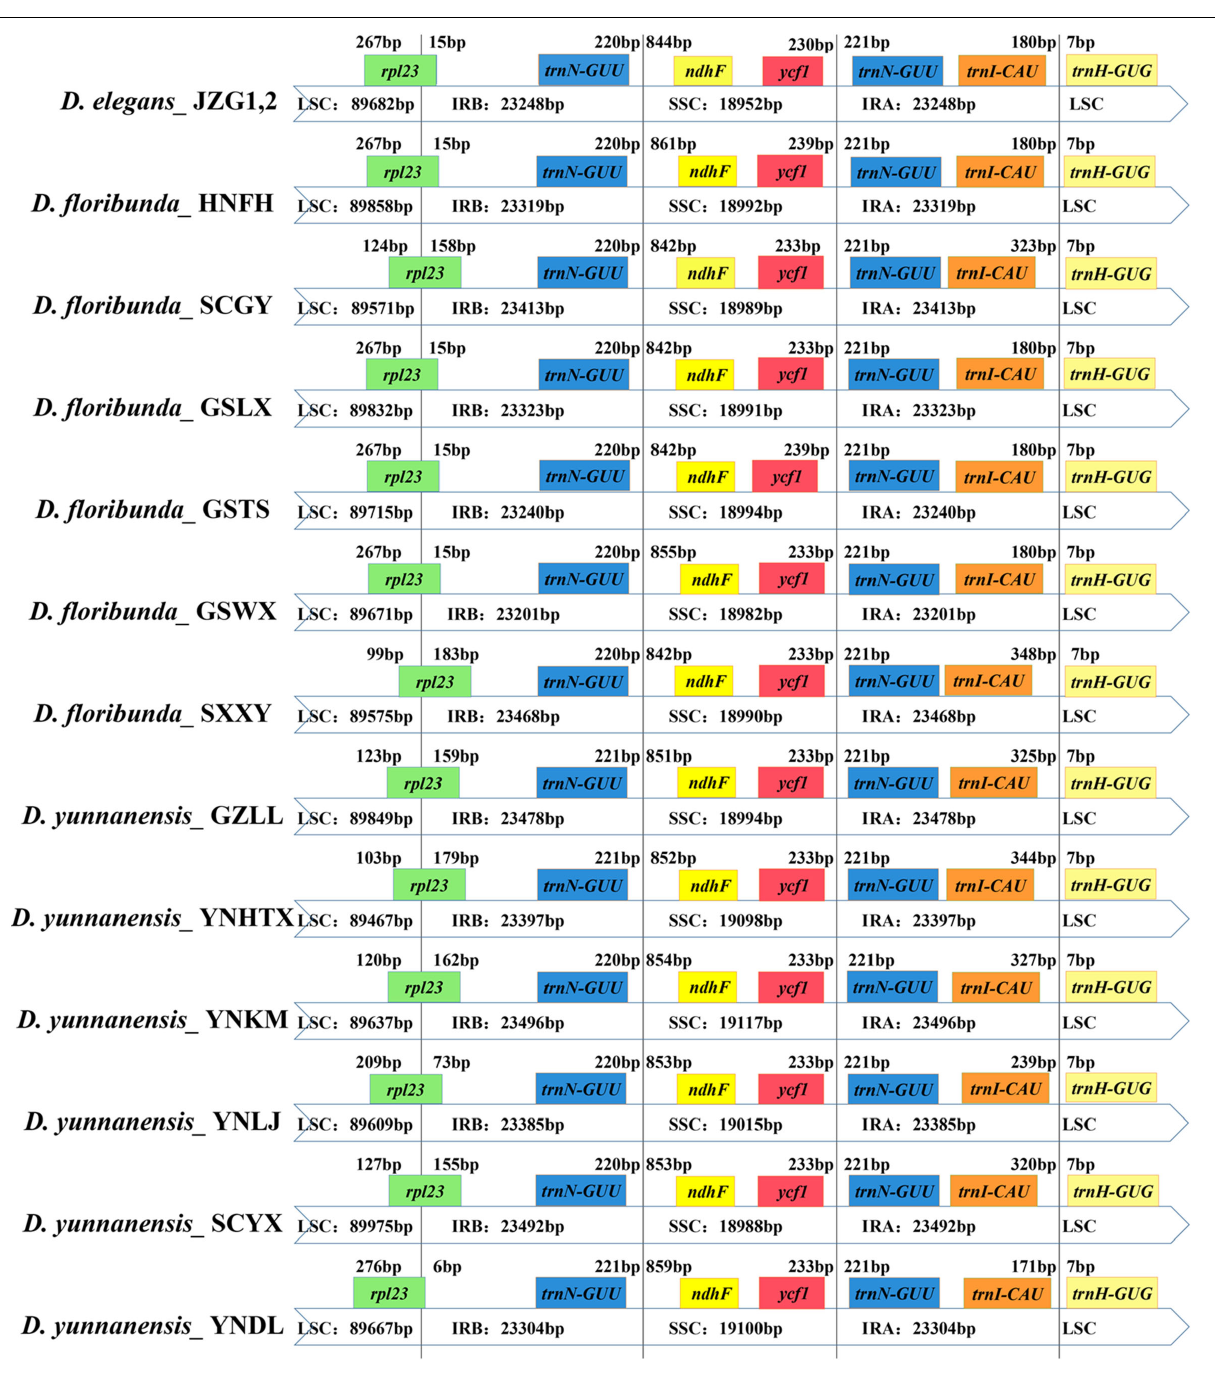
codon usage bias was found in ACC for threonine and GCC for alanine in mitogenomes, both of which were less used in plastomes. The difference in favored codon usage pattern was closely related to the origin and evolutionary history of two organellar genomes (Xu et al., 2015). In Triticum aestivum , neutral mutation and translation coupled factors played a critical